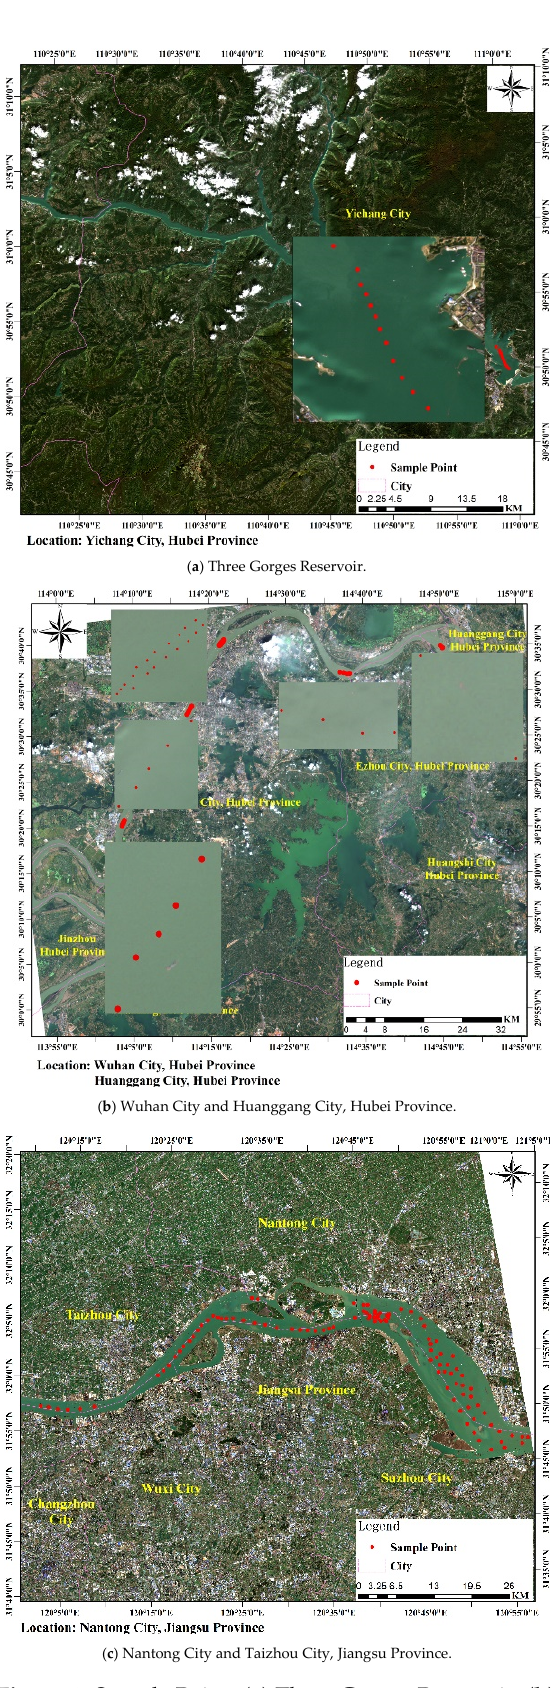
Figure 3. Scatterplots showing the derivation of the accuracies of Sentinel-2 derived SDD in com- parison with in situ SDD.